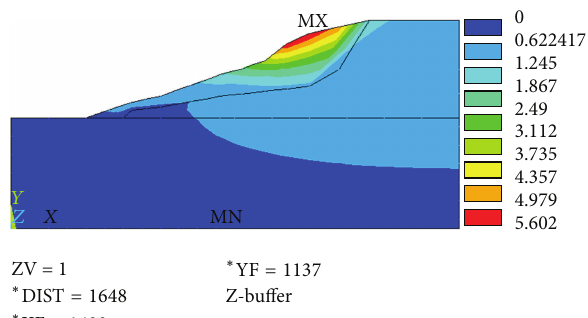
Figure 10: Comprehensive displacement nephogram of the QC10 section.